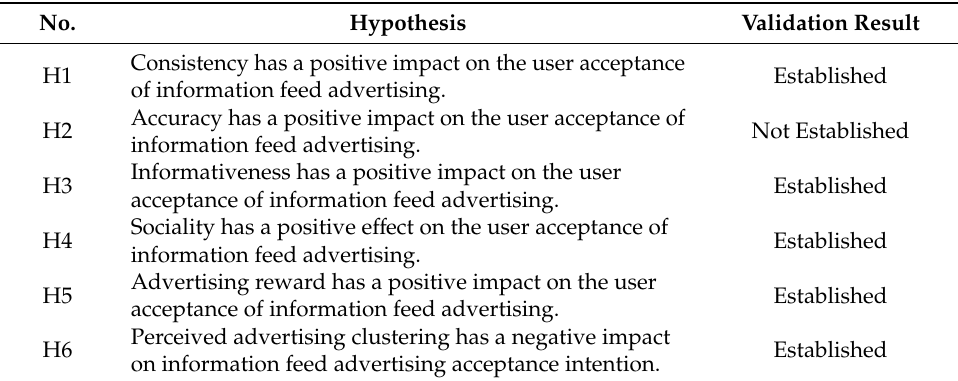
Table 5. Summary of hypotheses validation in the SEM